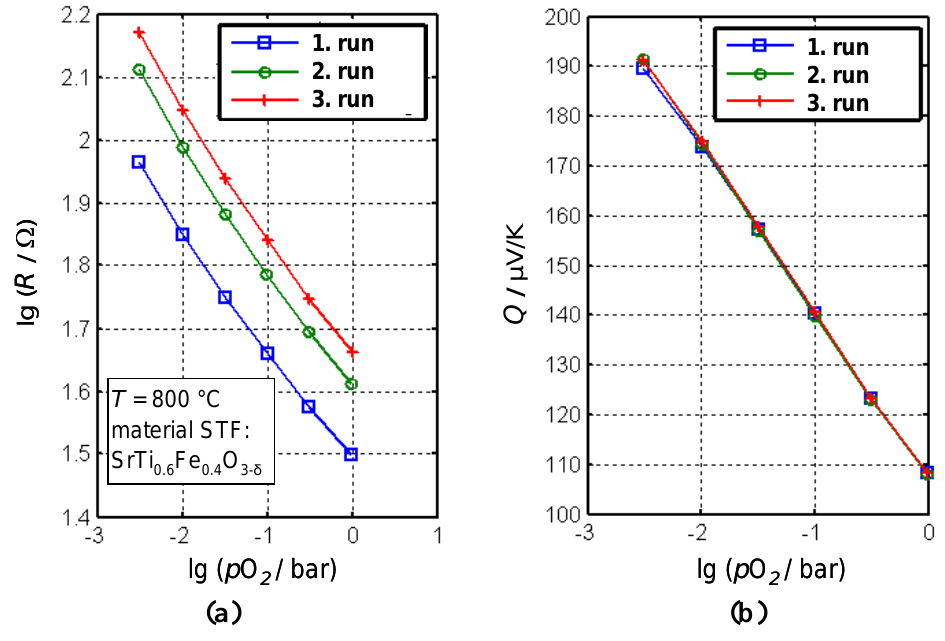
Figure 11. (a) Resistance, R , and (b) thermopower (Seebeck coefficient), Q , of a porous STF specimen when exposed to different oxygen partial